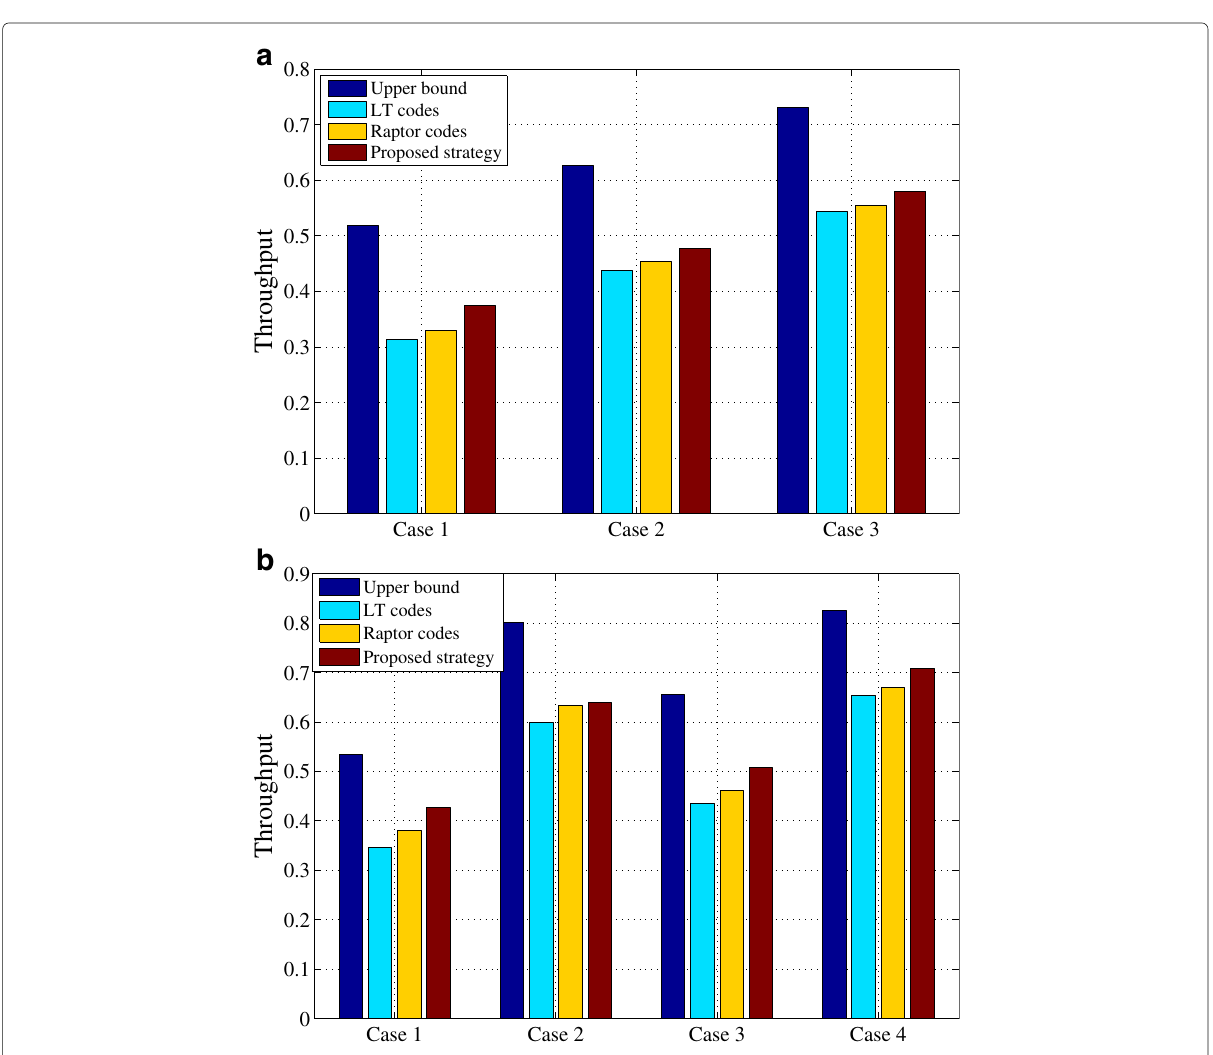
Fig. 6 Throughput performance of our proposed coding scheme compared with conventional LT and Raptor codes. Throughput over MDEC with exponential L ∼ E (λ) and non-negative Gaussian distributed L ∼ | N (μ , σ 2 ) | channel life spans. The subfigure titles are a Exponential distribution and b Non-negative Gaussian